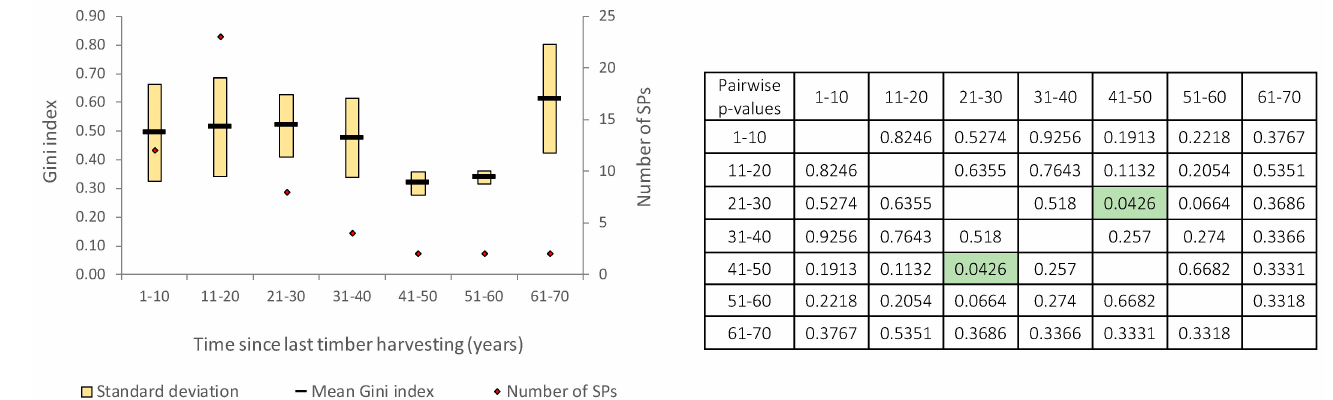
Figure 4. Effect of past harvesting intensity on current forest structure diversity.